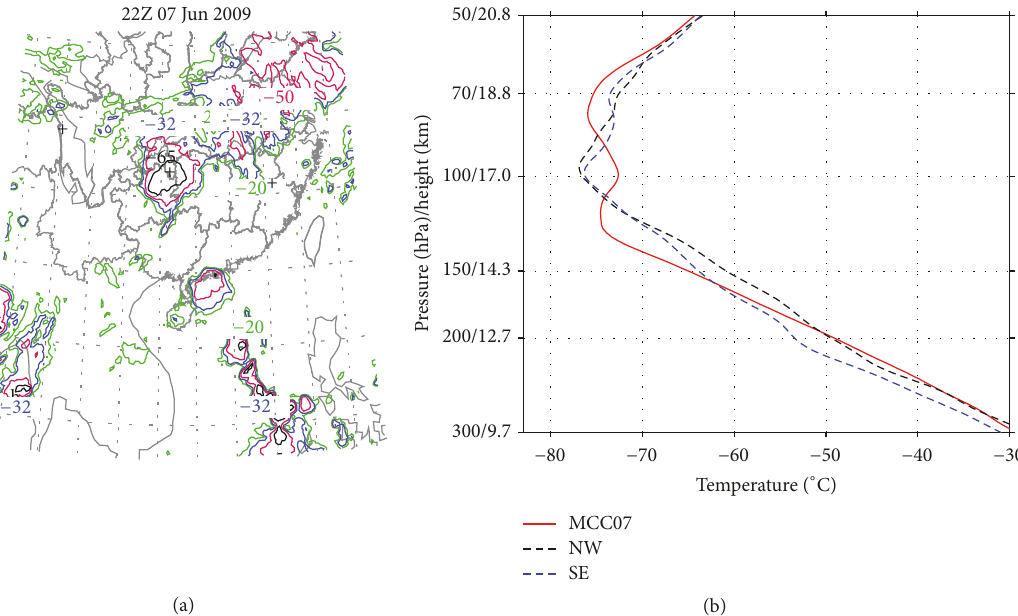
Figure 4: (a) Black-body temperature (green, blue, red, and black contours denote − 20, − 32, − 50, and − 65 ∘ C, resp.) from the FY2C satellite on 7 June 2009; + symbols indicate locations inside and outside the MCC at 15km from the GPS radio occultation temperature profiles. (b) GPS radio occultation temperature profiles on 7 June 2009 inside (red curves) and outside (blue in southeast and black in northwest) the